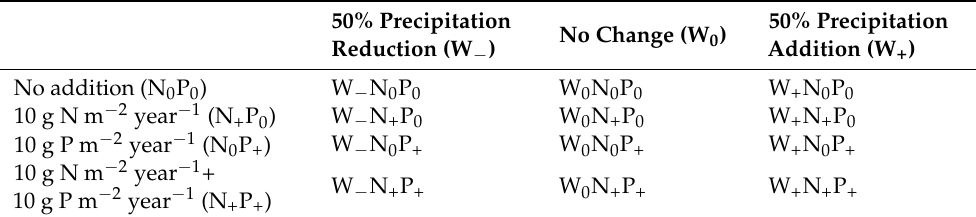
Table 1. Description and abbreviations of the 12 treatments in this